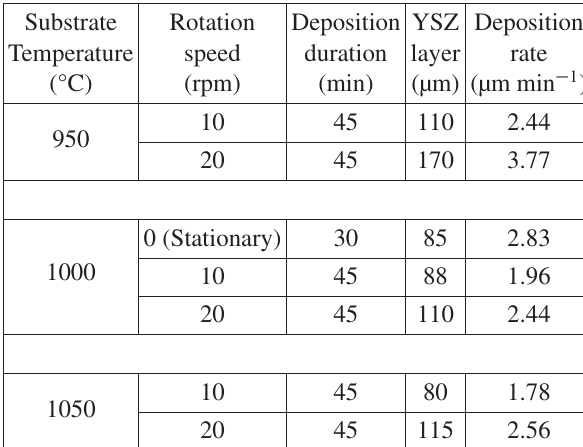
Figure 7. The 7YSZ coating deposited on a stationary (0 rpm = 1000°C) sample: (a) surface morphology and (b) cross-sectional microstructure.